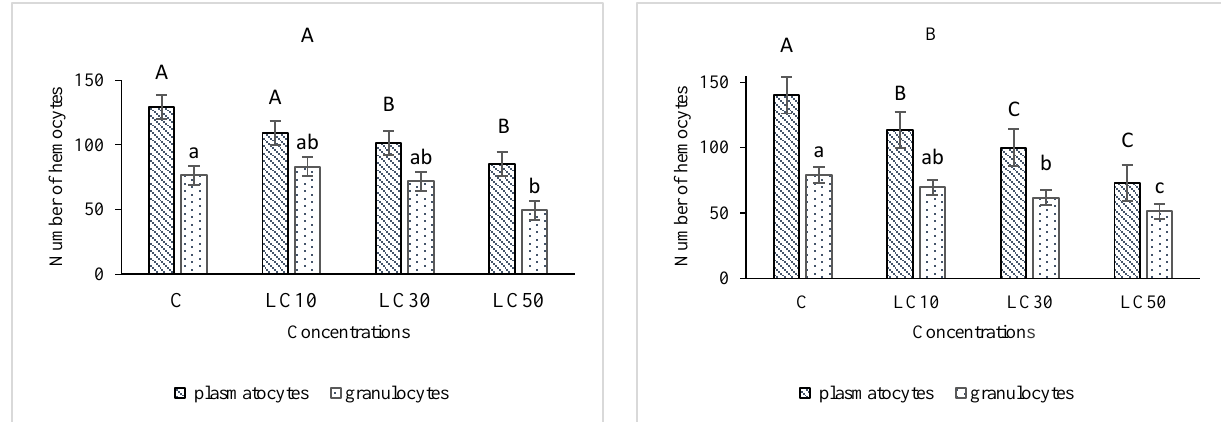
Figure 2. The effect of Artemisia annua floral essential oil on the plasmatocytes and granular cells of Glyphodes pyloalis larvae treated with oral ( A ) and fumigant ( B ) assays. Bars with different letters indicate significant differences among means of each hemocyte at p < 0.05, Tukey’s test. The number of hemocytes ×10 4 .